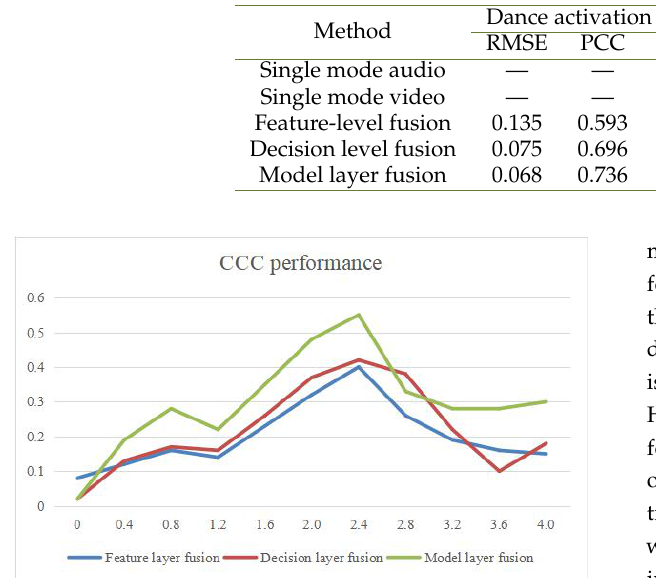
Table 2. Experiment result of single-model and three multi-modal fusion methods.